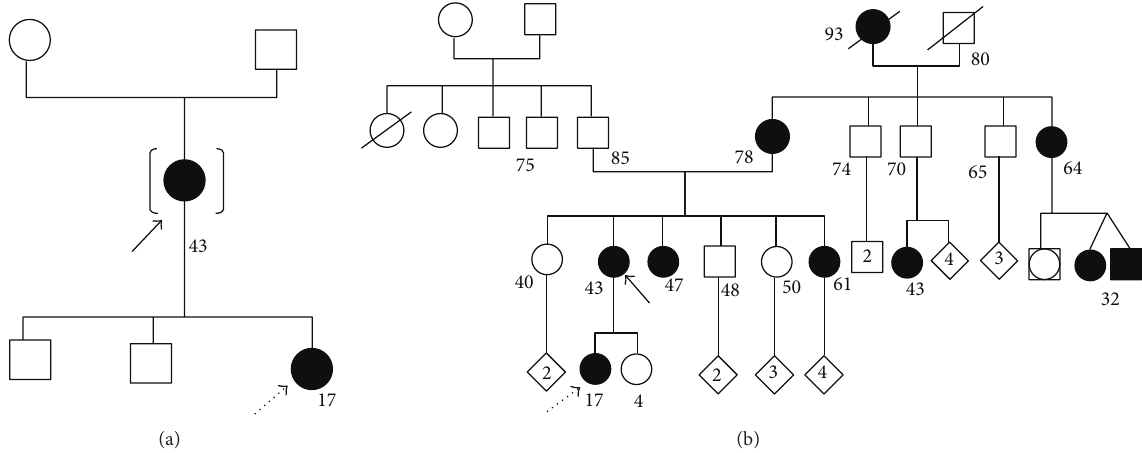
Figure 3: Genetic family trees of case 1 (a) and case 2 (b). The continuous black arrows indicate the mothers and the dotted black arrows indicate the